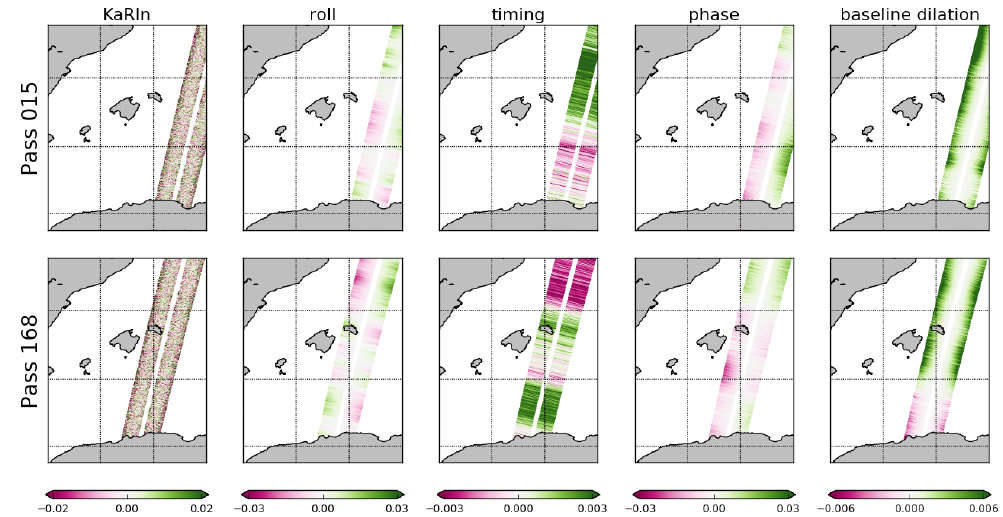
Figure A3. The different instrument noise types (m) for passes 15 pass 168 over cycle 2 are shown.